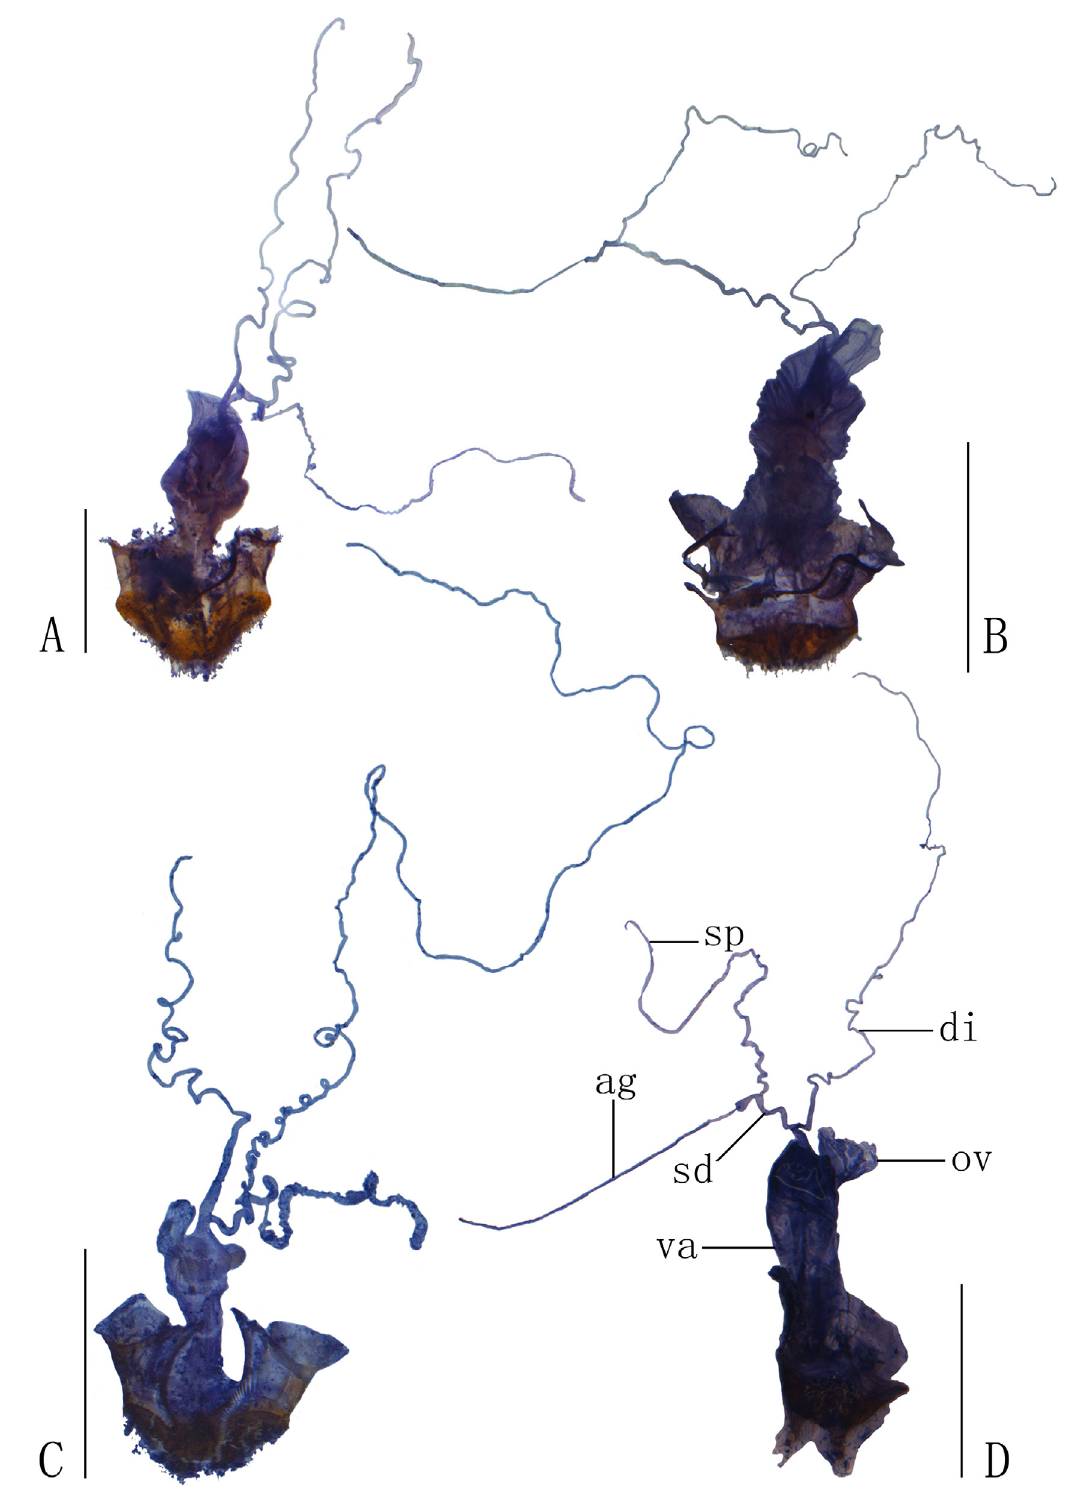
Fig. 6. Female internal reproductive system, lateral view. A . Stenothemus biimpressiceps (Pic,